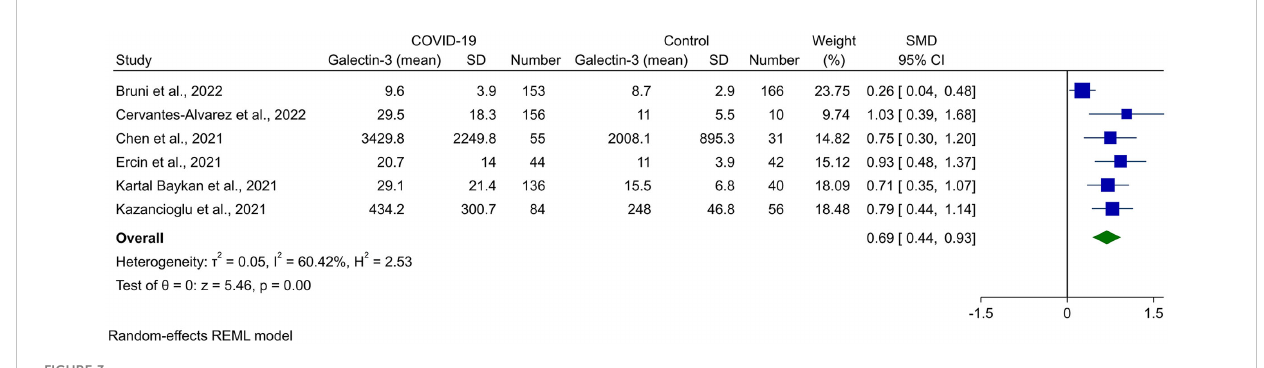
TABLE 2 Meta-regression of COVID-19 vs. controls and Severe vs. non-severe COVID-19 meta-analyses. No. of subjects Meta-regression Moderator Case Control